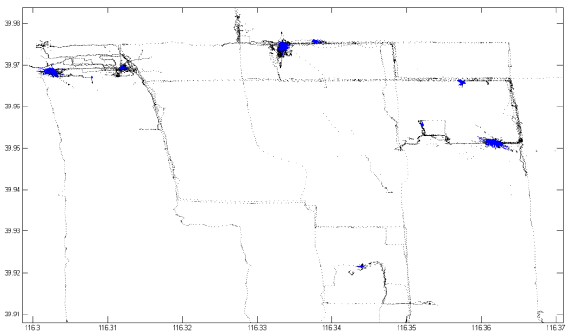
Figure 4. Clustered line segments of an individual However, the segments clusters are so highly overlapped in space that it is difficult to understand the spatial-temporal clustering results by the expression of the above-described two-dimensional plane. For that, we display the representative clustered hot spots in a vision of three-dimension. Figure 5 shows the result. We gather 15 users’ clustered hot spots which were achieved by our clustering algorithm. X axis represents the latitude, Y the longitude and Z the time. Black lines in the X-Y coordinate space display trajectories, and blue points in three-dimensional space-time represent clustered hot spots. Here, the number of clusters is that of blue points. Since the absolute time spot of people’s trajectories was taking into account, we know that the points at the same Z axis (time) in the vertical direction stand for people’s clustered hot spots which are at the same location but different moments. It can be a representation for the temporal evolution of people’s trajectories hot spots. Moreover, the points on the same horizontal plane at one time are on behalf of the spatial distribution of people’s clustered hot spots at that